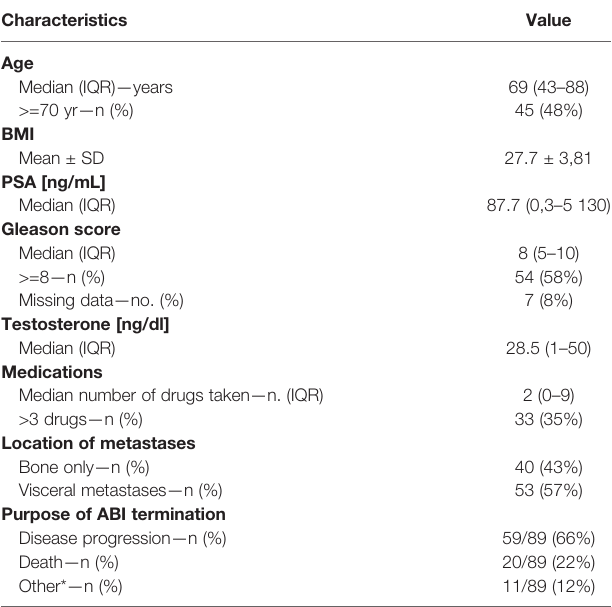
TABLE 1 | Characteristics of the patients at baseline.